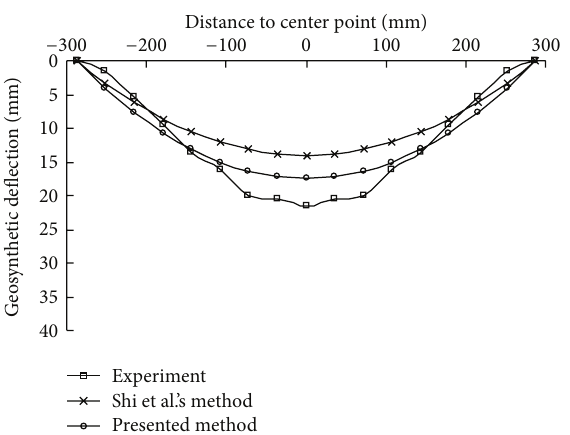
Figure 12: Comparison of deflections along the diagonal.